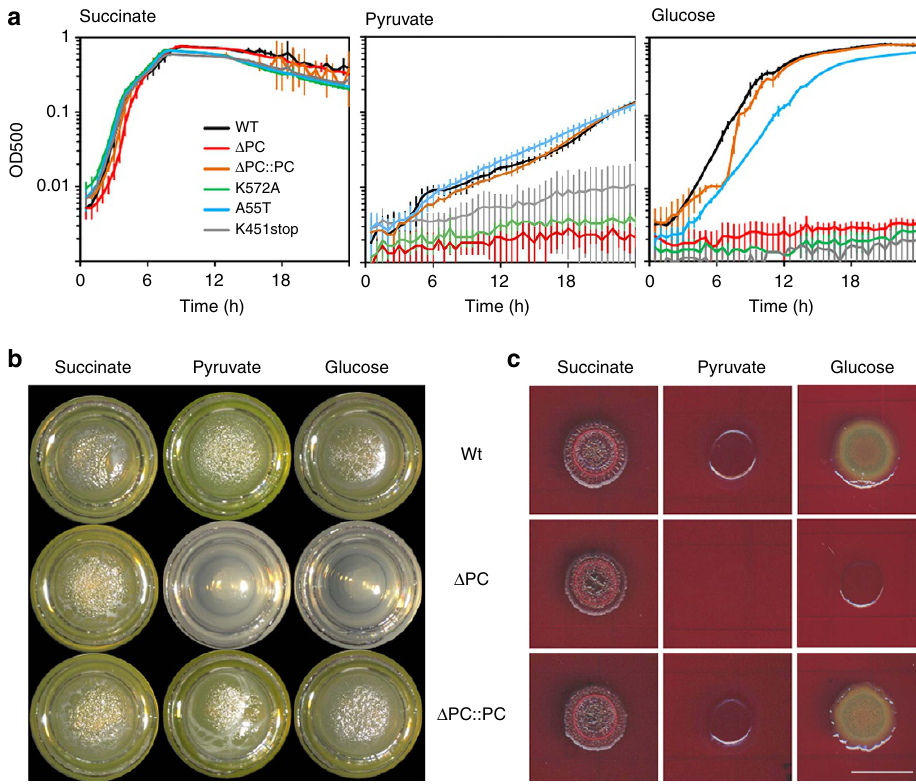
Figure 6 | The two-subunit PaPC is required for growth on selected carbon sources. ( a ) Shaken liquid-culture growth of wild-type P. aeruginosa PA14, D PC , the PC-complemented strain and various site-specific mutants in a defined medium containing 20mM succinate, pyruvate or glucose as the sole carbon source. Each growth curve represents the average of three biological replicates. Error bars denote s.d. ( b ) Pellicles formed by P. aeruginosa PA14, D PC , and the PC-complemented strain on a defined medium containing succinate, pyruvate, or glucose as the sole carbon source. ( c ) Colony morphology of P. aeruginosa PA14, D PC and the PC-complemented strain on a defined medium (supplemented with 1% agar, Congo red and Coomassie blue) containing succinate, pyruvate or glucose as the sole carbon source. Images depict day 3 of colony